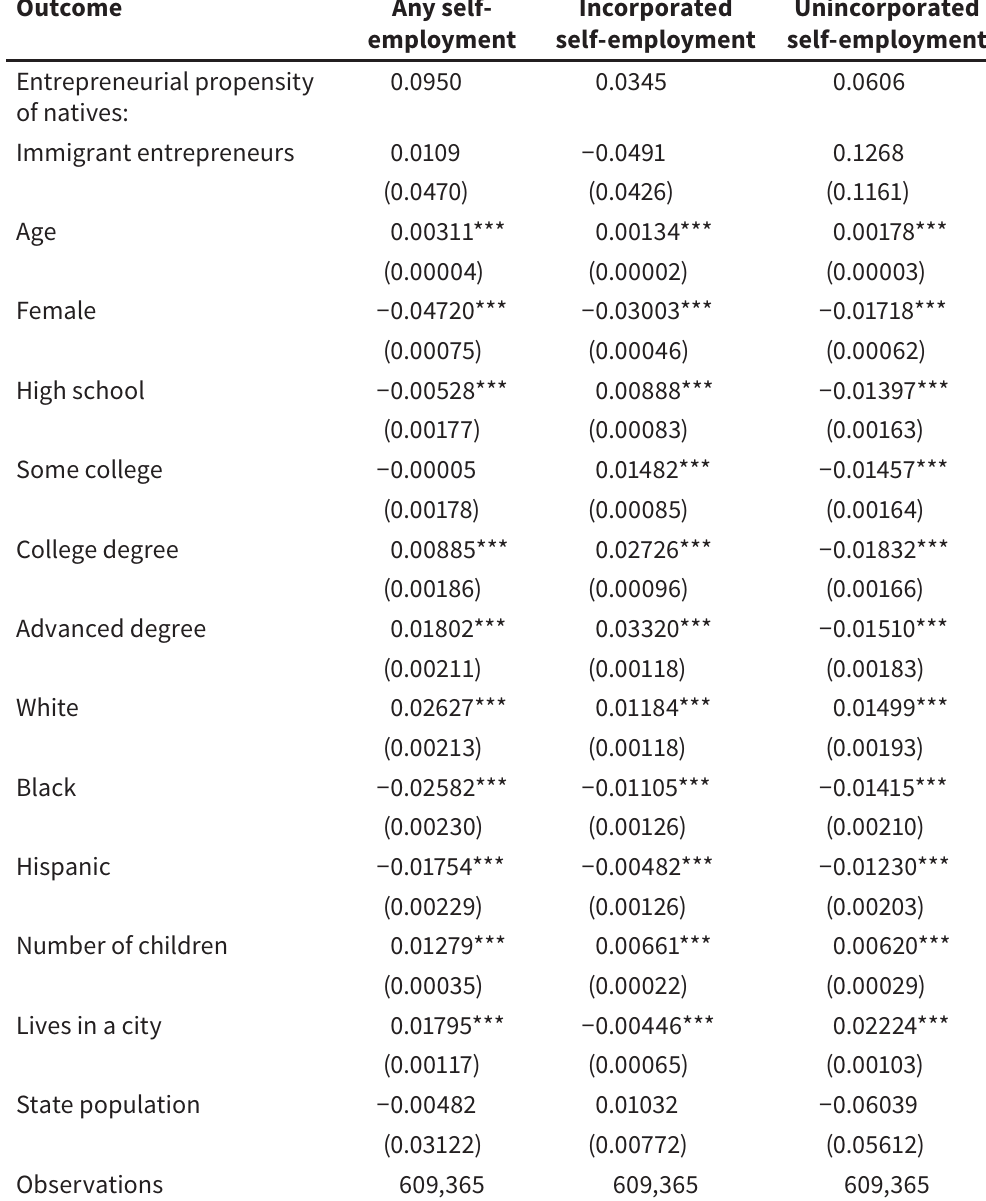
Impact of Supply of Immigrant Entrepreneurs on Entrepreneurial